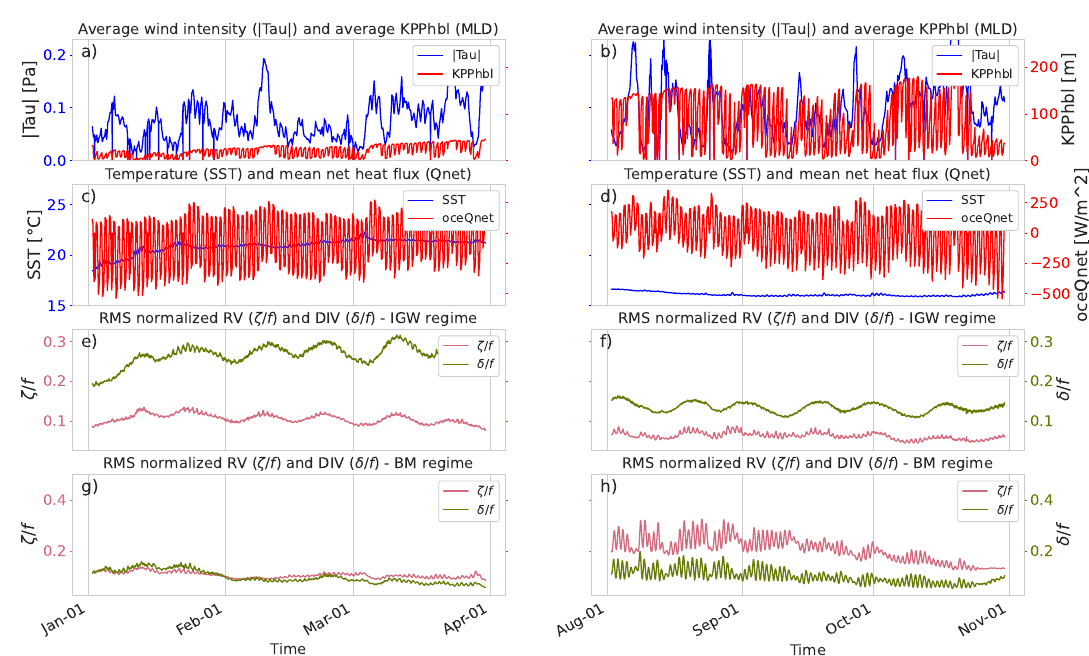
Figure 10. Time series of dynamical variables for the study area centered at 26.6 ◦ S within the Benguela current from 2 January to 30 March 2012 ( a , c , e , g ) and from 2 August to 30 October 2012 ( b , d , f , h ) seasons. First row ( a , b ): mean values for the wind stress ( | τ | , blue) and the KPP turbulent boundary layer depth ( KPP hbl , red). Second row ( c , d ): mean values for the sea surface temperature (T, blue) and the ocean net heat flux (oceQnet, red). Third row ( e , f ): standard deviation of the normalized vorticity ( ζ / f , magenta) and divergence ( δ / f , green) fields in the internal gravity wave (IGW) regime. Fourth row ( g , h ): standard deviation of the normalized vorticity ( ζ / f , magenta) and divergence ( δ / f , green) fields in the balanced motion (BM)